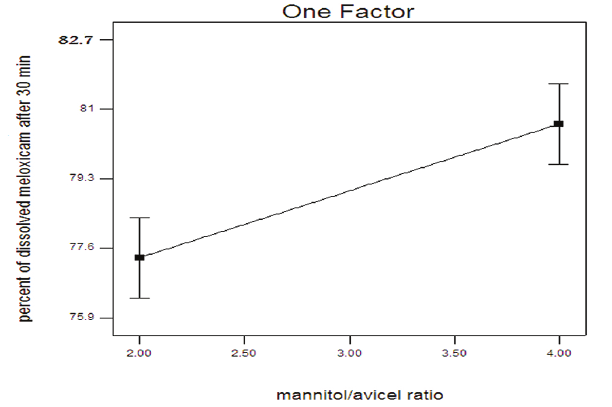
FIGURE 6 - The effect of mannitol/avicel ratio on the percent of dissolved meloxicam that dissolved after 30 min in the dissolution medium.